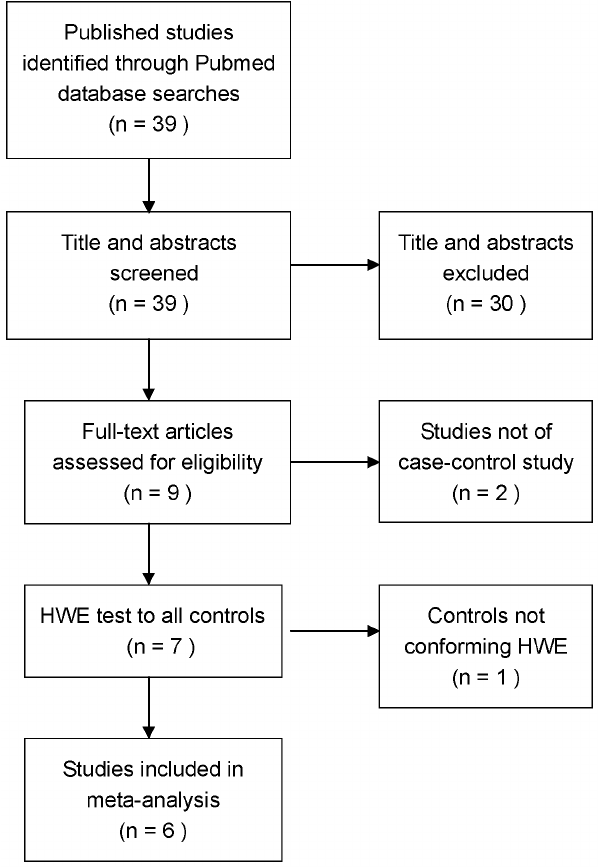
Figure 1. The process of identifying relevant studies is